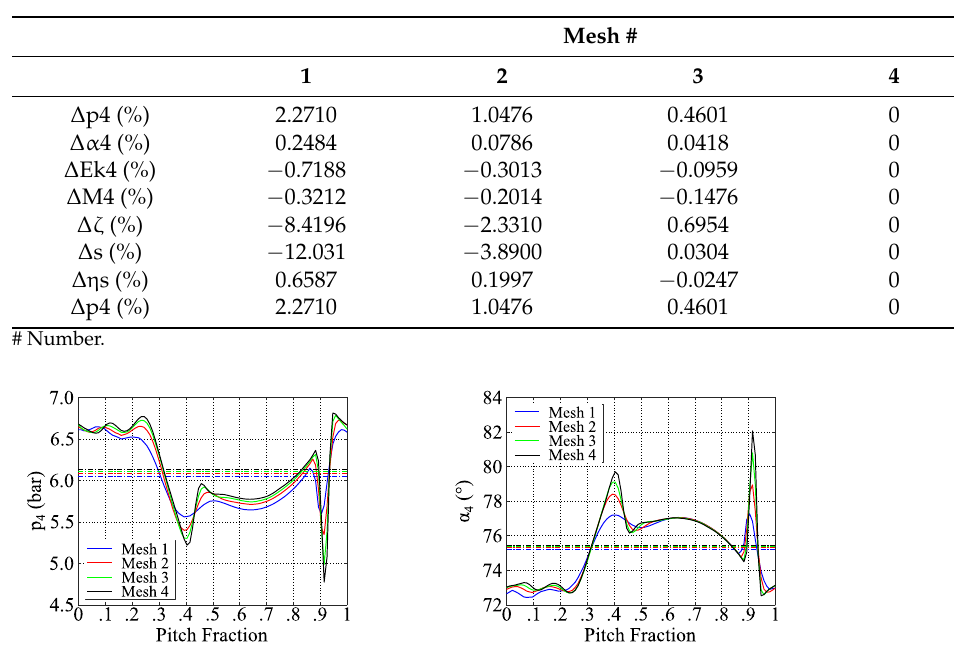
Table 3. Percentual variation of relevant quantities with mesh size: finest mesh taken as reference.